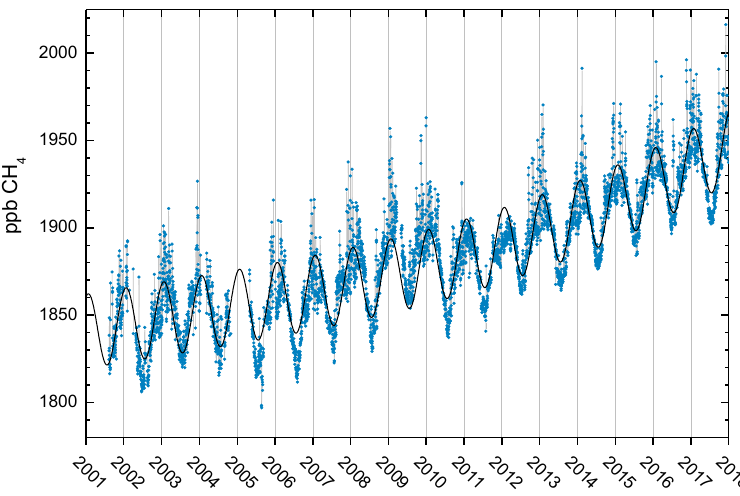
Figure 3. Observations of daily averaged CH 4 mixing ratio for the period 2001–2017 at the Zeppelin Observatory. The blue dots are daily mean mixing ratios in ppb, and the black solid line is the empirically fitted CH 4 mixing ratio (Eq. 1).